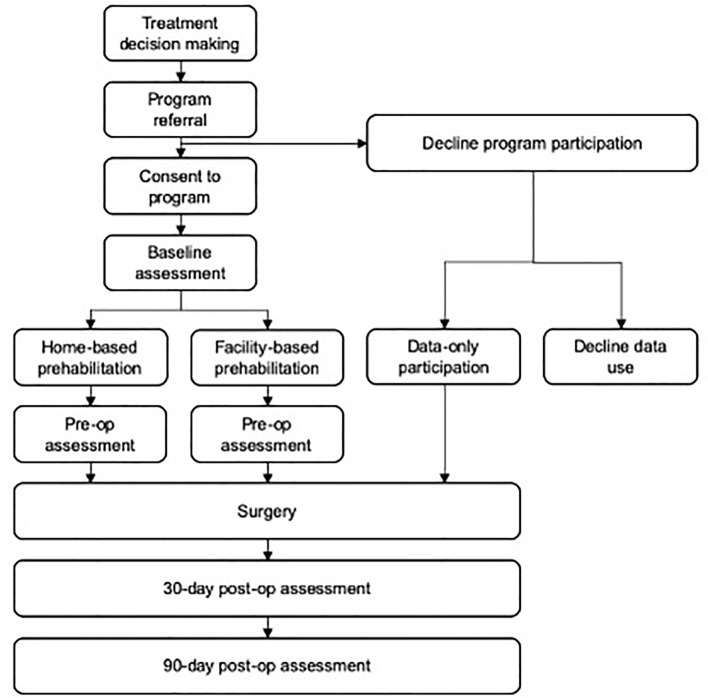
Participant flow.